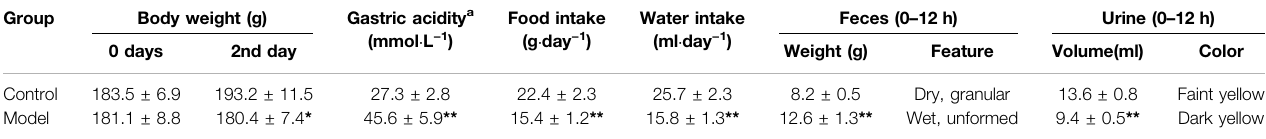
TABLE 2 | Comparison of general behaviors and gastrointestinal functions of the rats after modeling (mean ± SD, n (cid:2) 10). Group